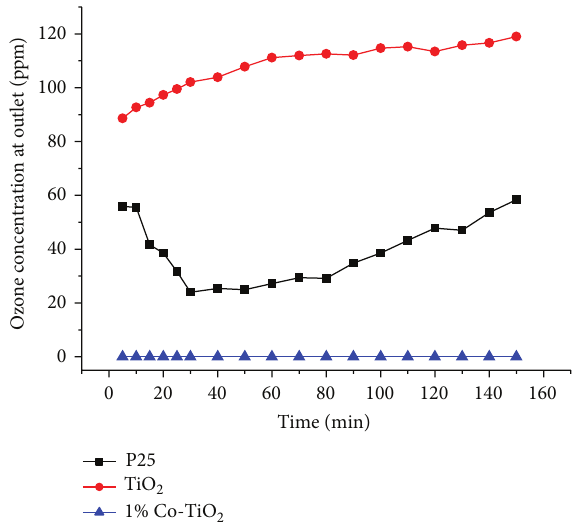
Figure 5: Ozone concentration at outlet of 185-PCO reactor with different photocatalysts.